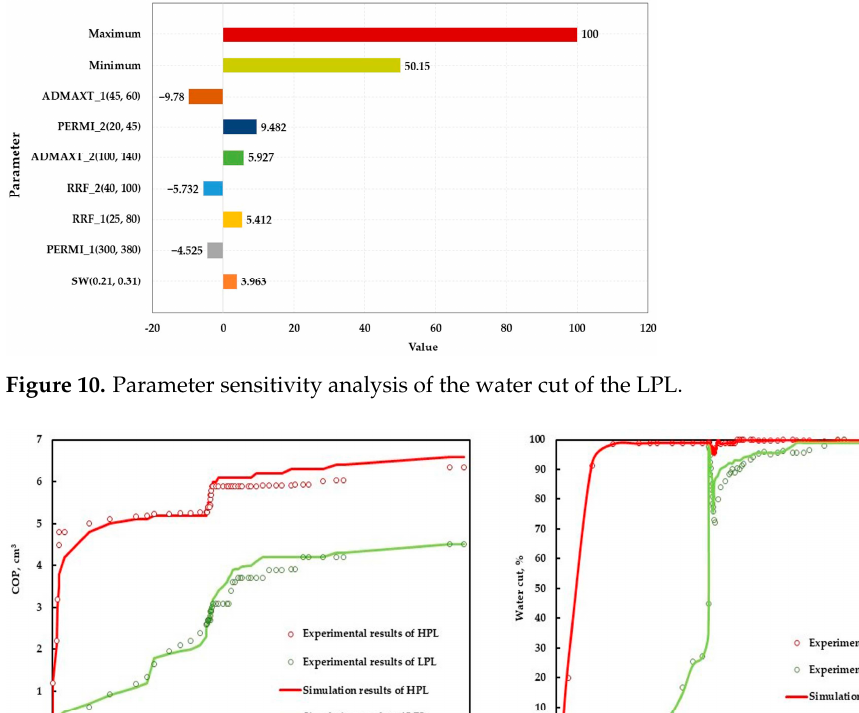
Figure 9. Parameter sensitivity analysis of the water cut of the HPL.